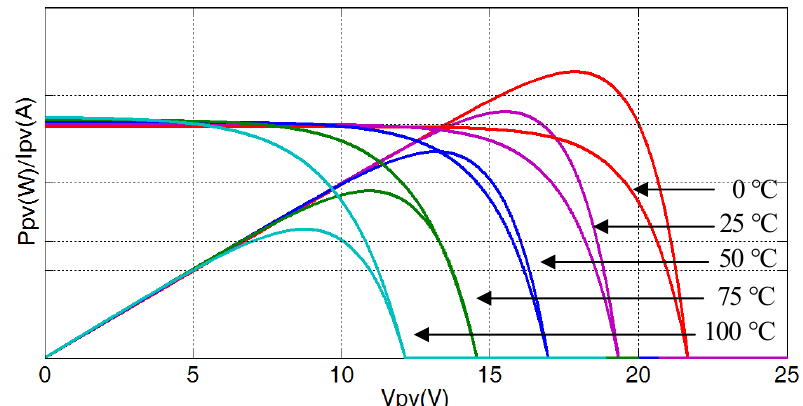
Figure 3. V-I and P-V characteristic curves of a solar cell.